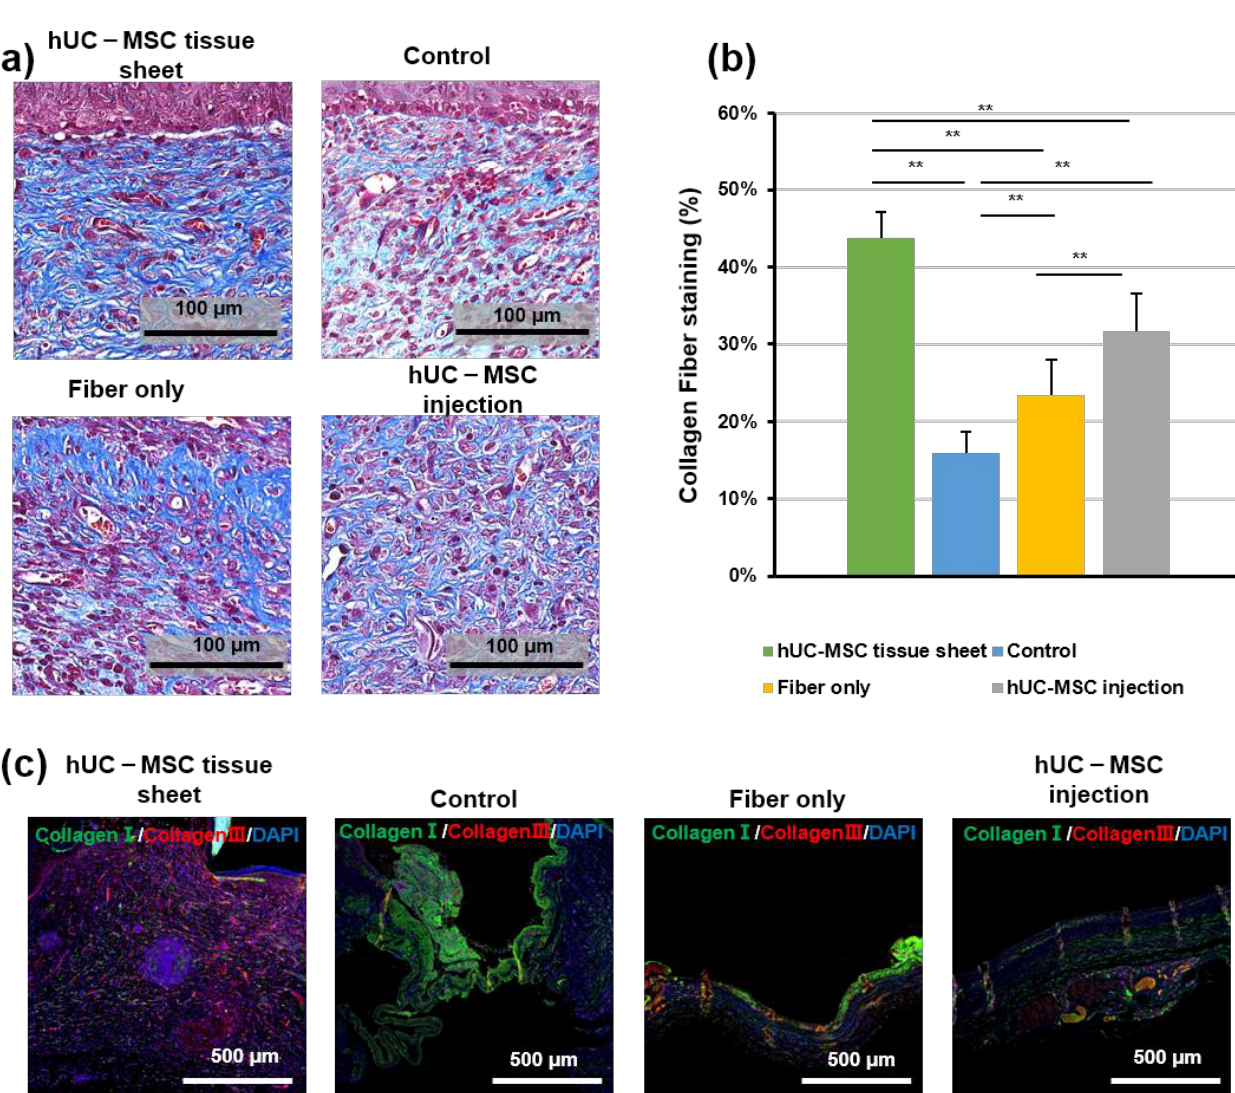
Figure 4. Human umbilical cord mesenchymal stem cell (hUC-MSC) tissue sheet induces collagen synthesis in vivo. ( a ) Masson staining of wound sections in different groups on day 14 after wounding. Scale bar = 100 µ m. ( b ) Quantitative analysis of collagen fiber deposition in different groups 14 days after wounding. ( c ) Immunohistological analysis of collagen I (green) and III (red). Scale bar = 500 µ m. Results are presented as mean ± SD. Significance was determined using analysis of variance ANOVA. ** p < 0.01.